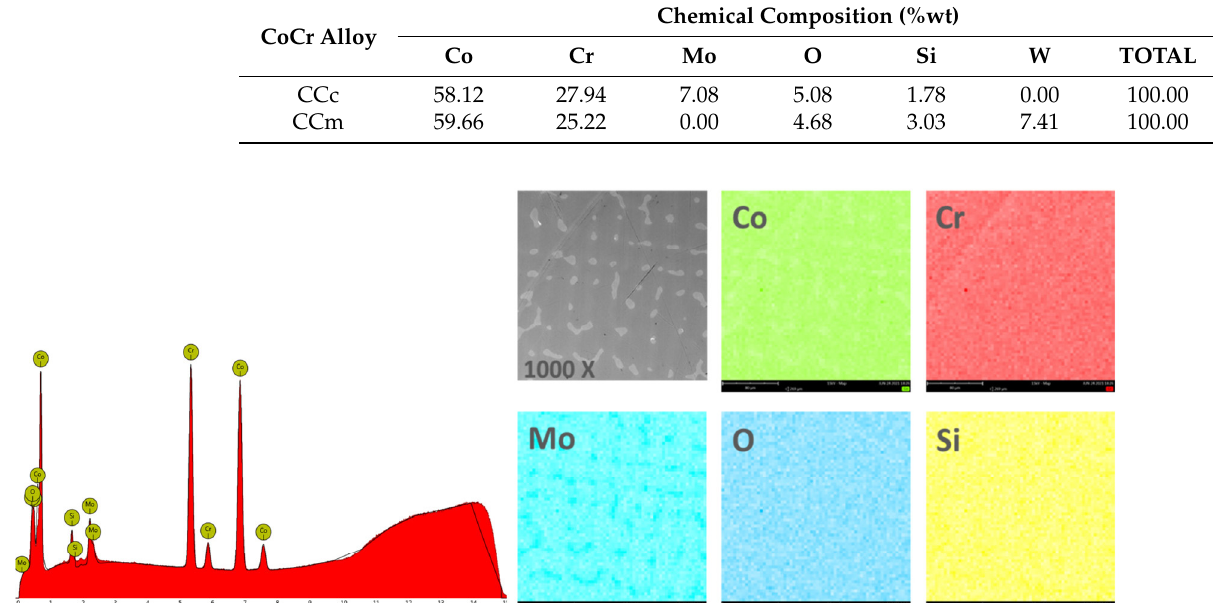
Figure 3. SEM images of the CCm (milled Co-Cr alloy) sample surface at: ( a ) 500×; ( b ) 3000×.